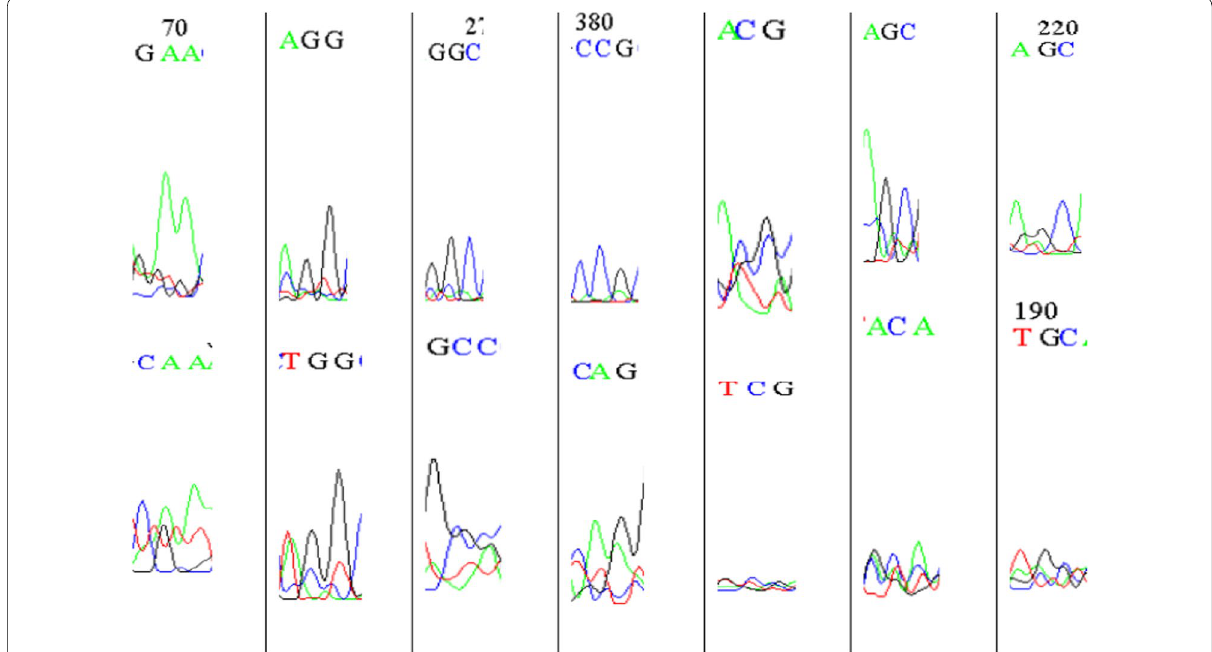
Fig. 3 Chromatograms of PCR amplicon sequencing showing DNA change in patients with PCOS compared to control. The upper chromatogram represents normal sequence obtained from control, while the lower chromatogram shows SNPs detected in PCOS